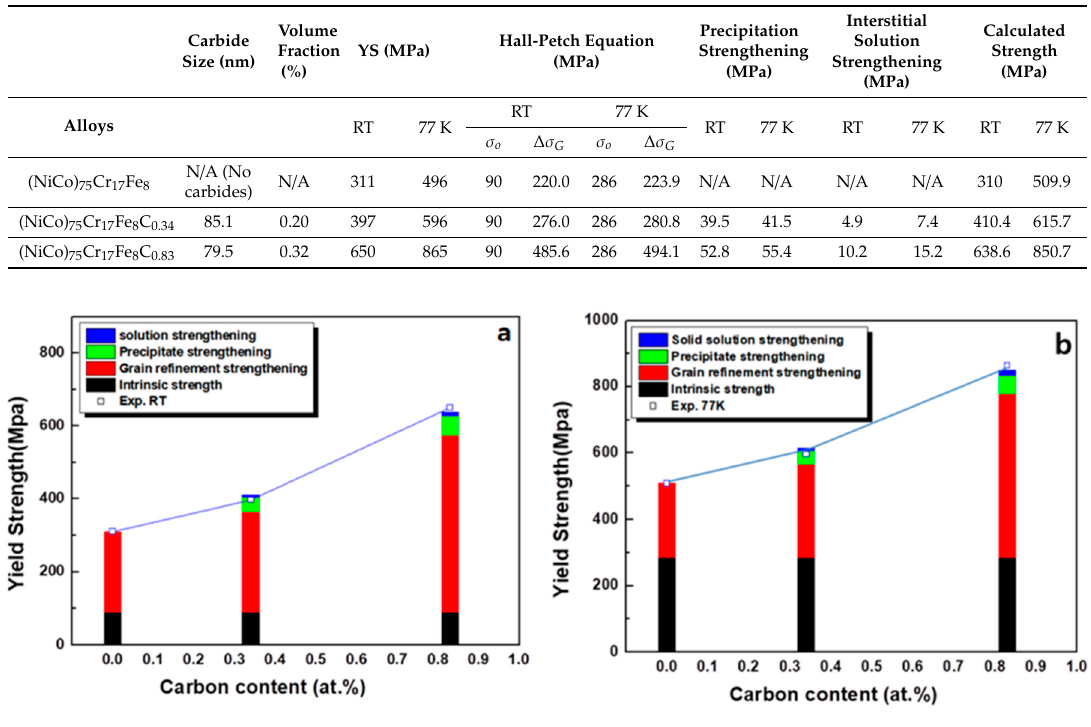
Figure 10. Predicted strengthening components including ∆ σ G by grain refinement, ∆ σ P by carbides, ∆ σ iS by interstitial solution strengthening of carbon and the friction stress due to intrinsic stress and substitutional solid solution strengthening ( σ 0 + ∆ σ SS ) are plotted with the experimental yield strengths of (NiCo) 75 Cr 17 Fe 8 , (NiCo) 75 Cr 17 Fe 8 C 0.34 and (NiCo) 75 Cr 17 Fe 8 C 0.83 at room ( a ) and cryogenic temperature ( b )